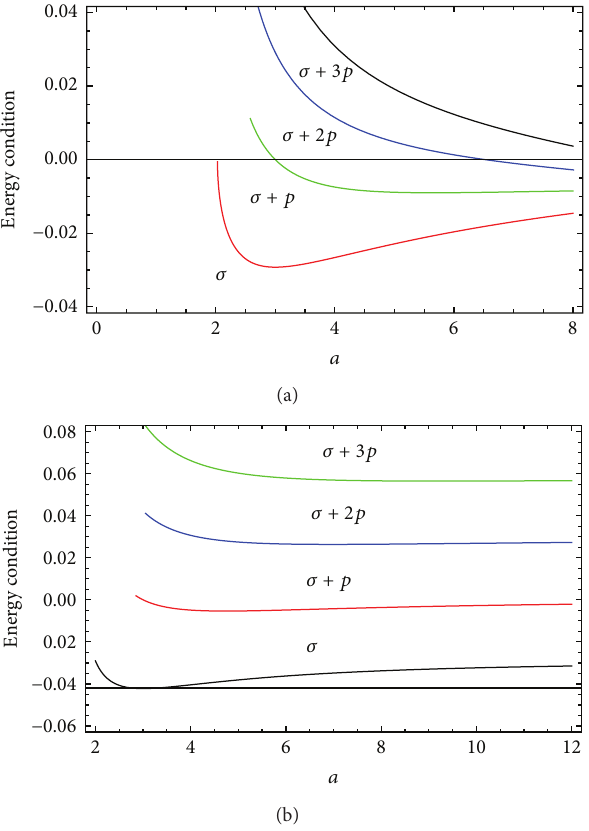
Figure 1: Plots of energy conditions for TSWs corresponding to 𝑀 = 1 , Λ = 0.01 (a) and 𝑀 = 1 , Λ = −0.1